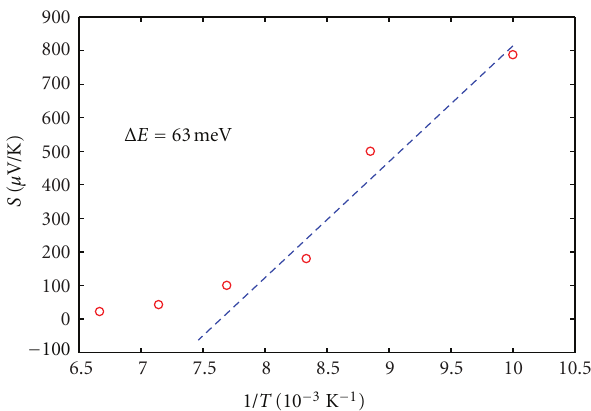
Figure 4: Extracted hopping activation energy, based on a hopping term S hop ∼ Δ E / T . Further discussion can be found in the